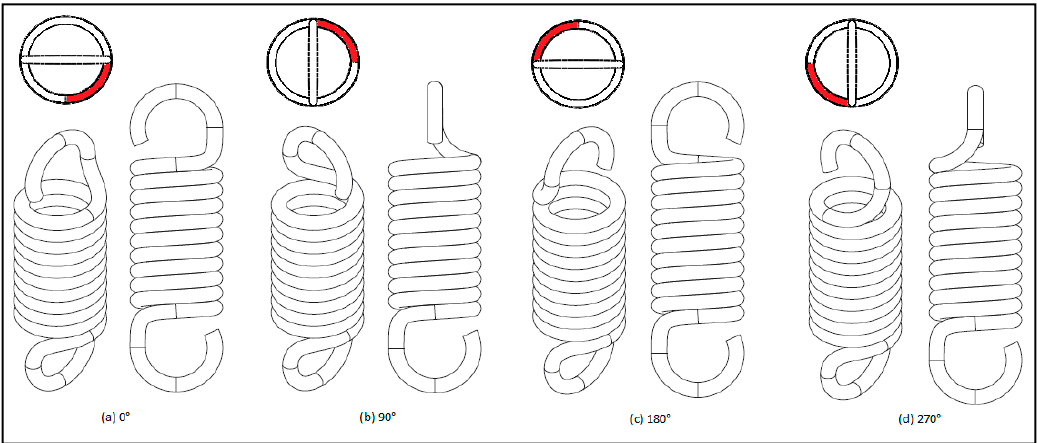
Figure 3. Hook orientations with varying degrees of offset ( a ) 0°, ( b ) 90°, ( c ) 180°, and ( d ) 270°; the bottom hook was taken as reference.